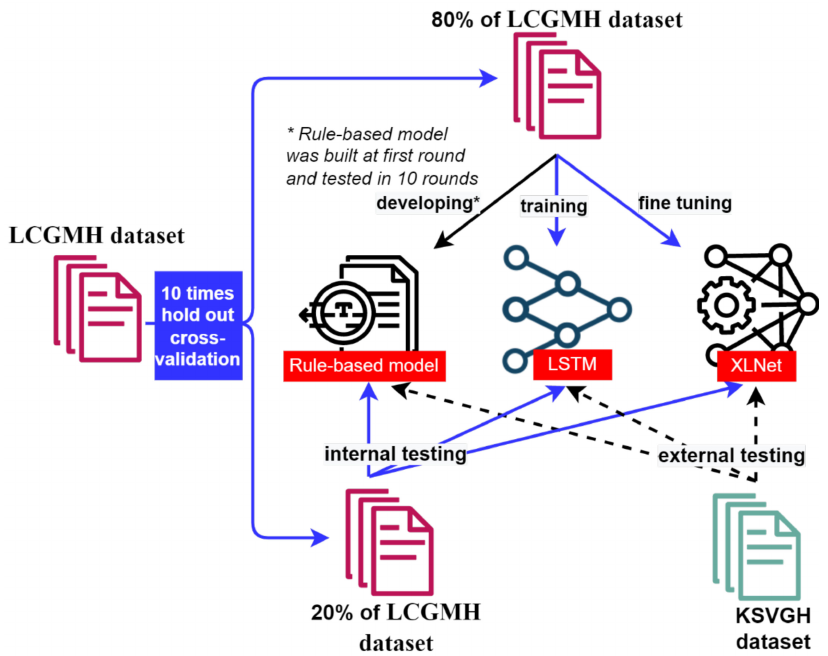
Figure 2. The process of model training, internal testing, and external testing. Three different models were trained on 80% of the Linkou Chang Gung Memorial Hospital (LCGMH) dataset, and were tested on 20% of the LCGMH dataset for internal testing. The Kaohsiung Veterans General Hospital dataset was used for external testing. * Rule-based model was built at first round and tested in 10